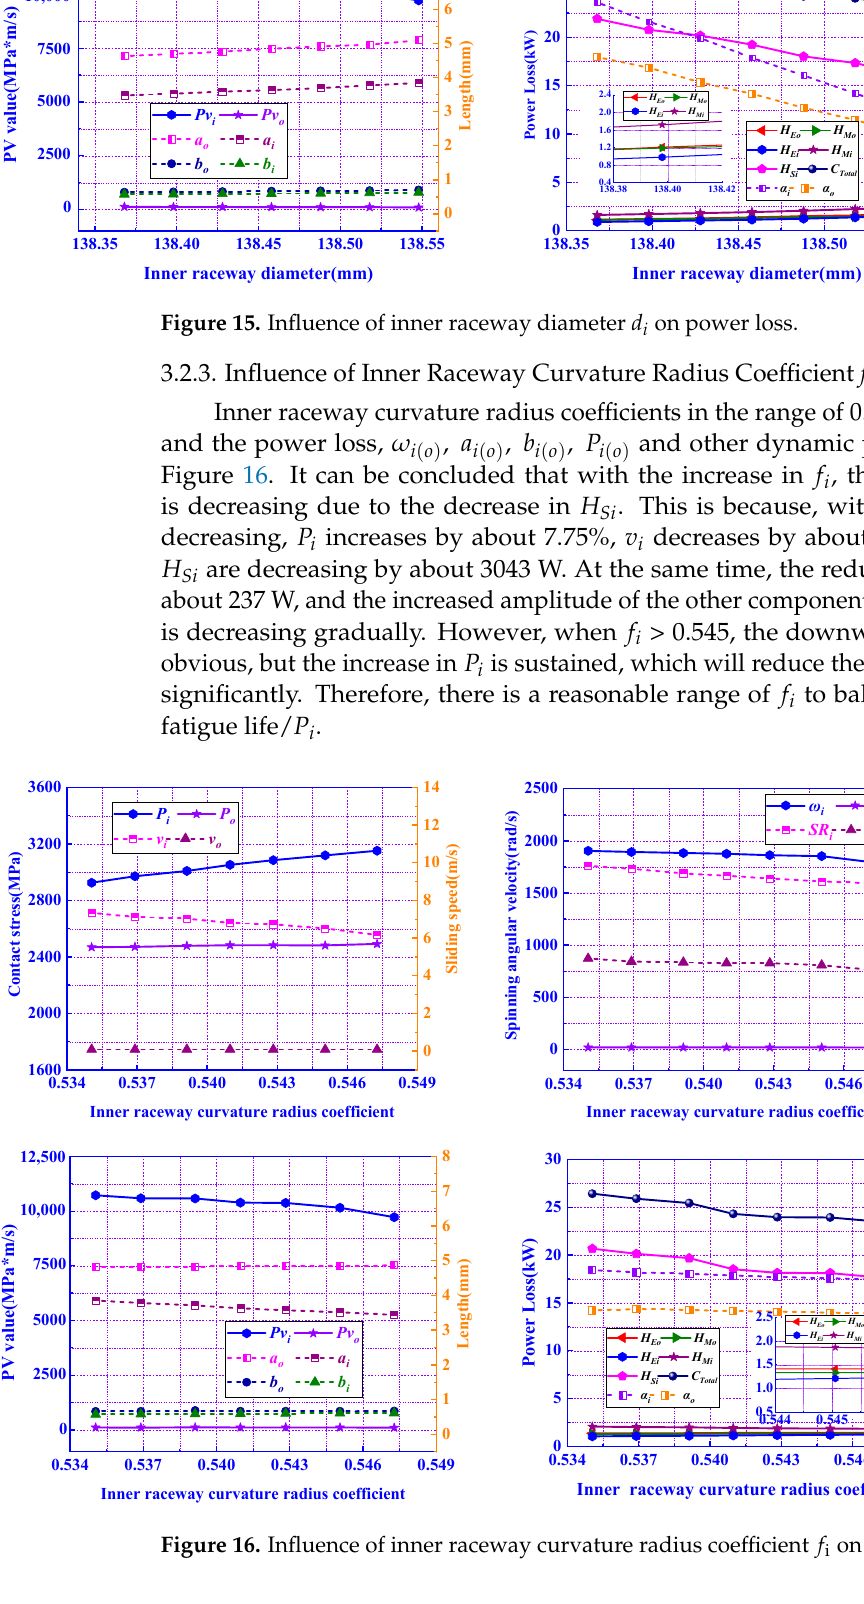
Figure 16. Influence of inner raceway curvature radius coefficient